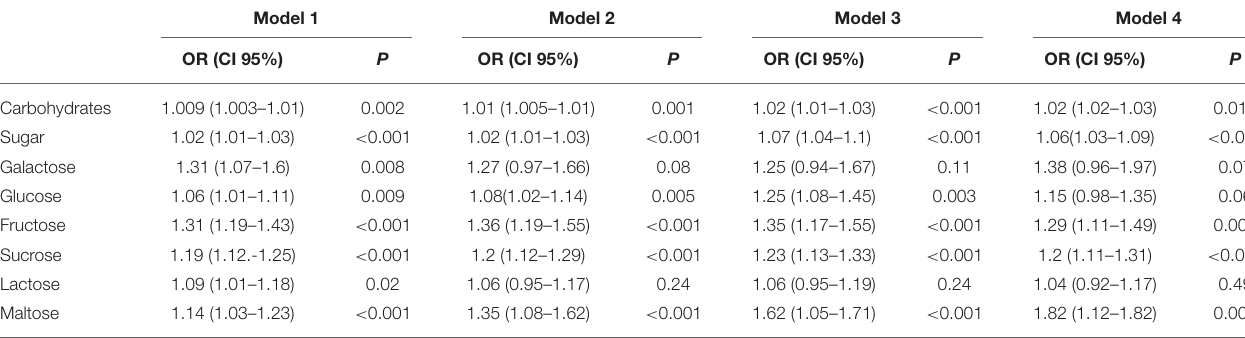
TABLE 3 | Logistic regression of the association between colorectal cancer and carbohydrate